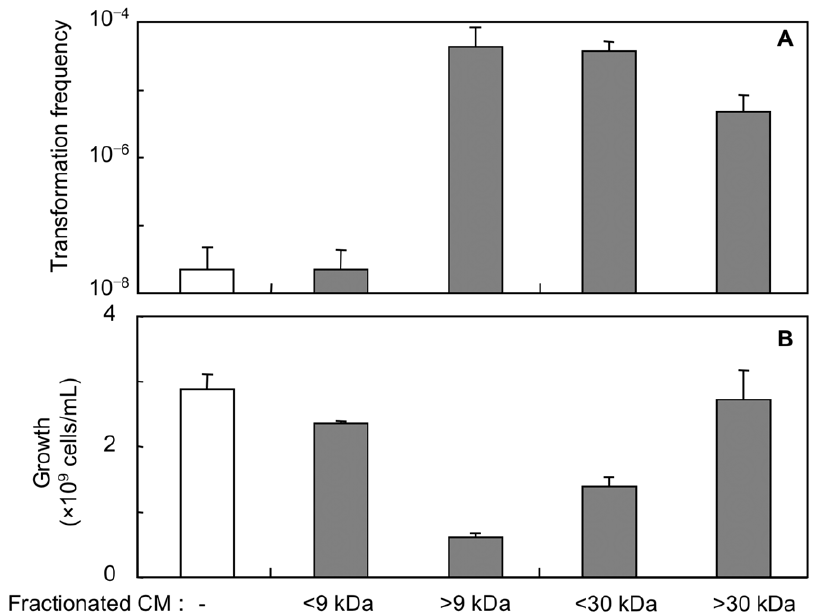
Figure 5. Effect of size fractionation of CM of CAG18439 on cell-to-cell transformation and cell growth. Effect of size fractionation of CM of CAG18439 on cell-to-cell transformation (A) and cell growth (B). CM was fractionated by ultrafiltration as described in Methods, and used for culture at 1% (v/v). Data are presented as mean and S.D. ( n =3). Co-culture of MG1655 harbouring pHSG299 and MC4100 was performed in the presence of CM.